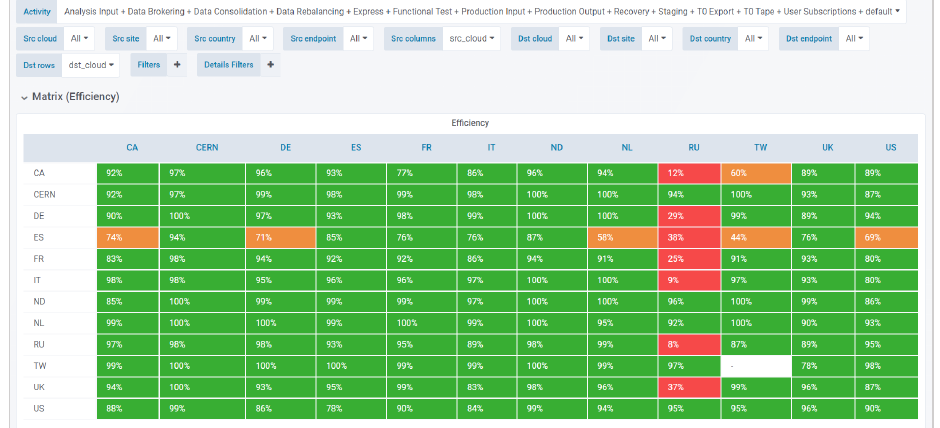
Fig. 6. Dashboard of the ATLAS DDM